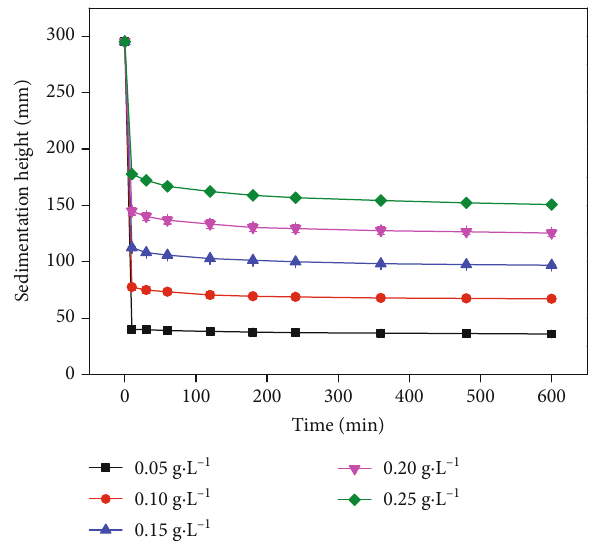
Figure 2: Sedimentation heights of aramid fi ber suspensions